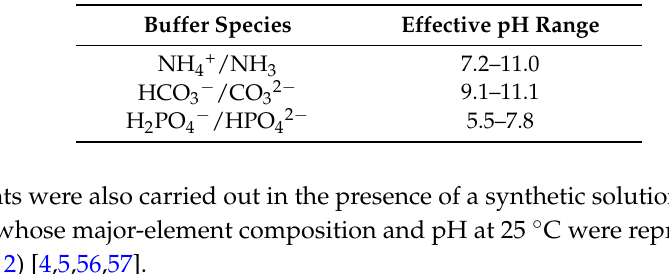
Table 1. The different buffer species with their effective pH range.